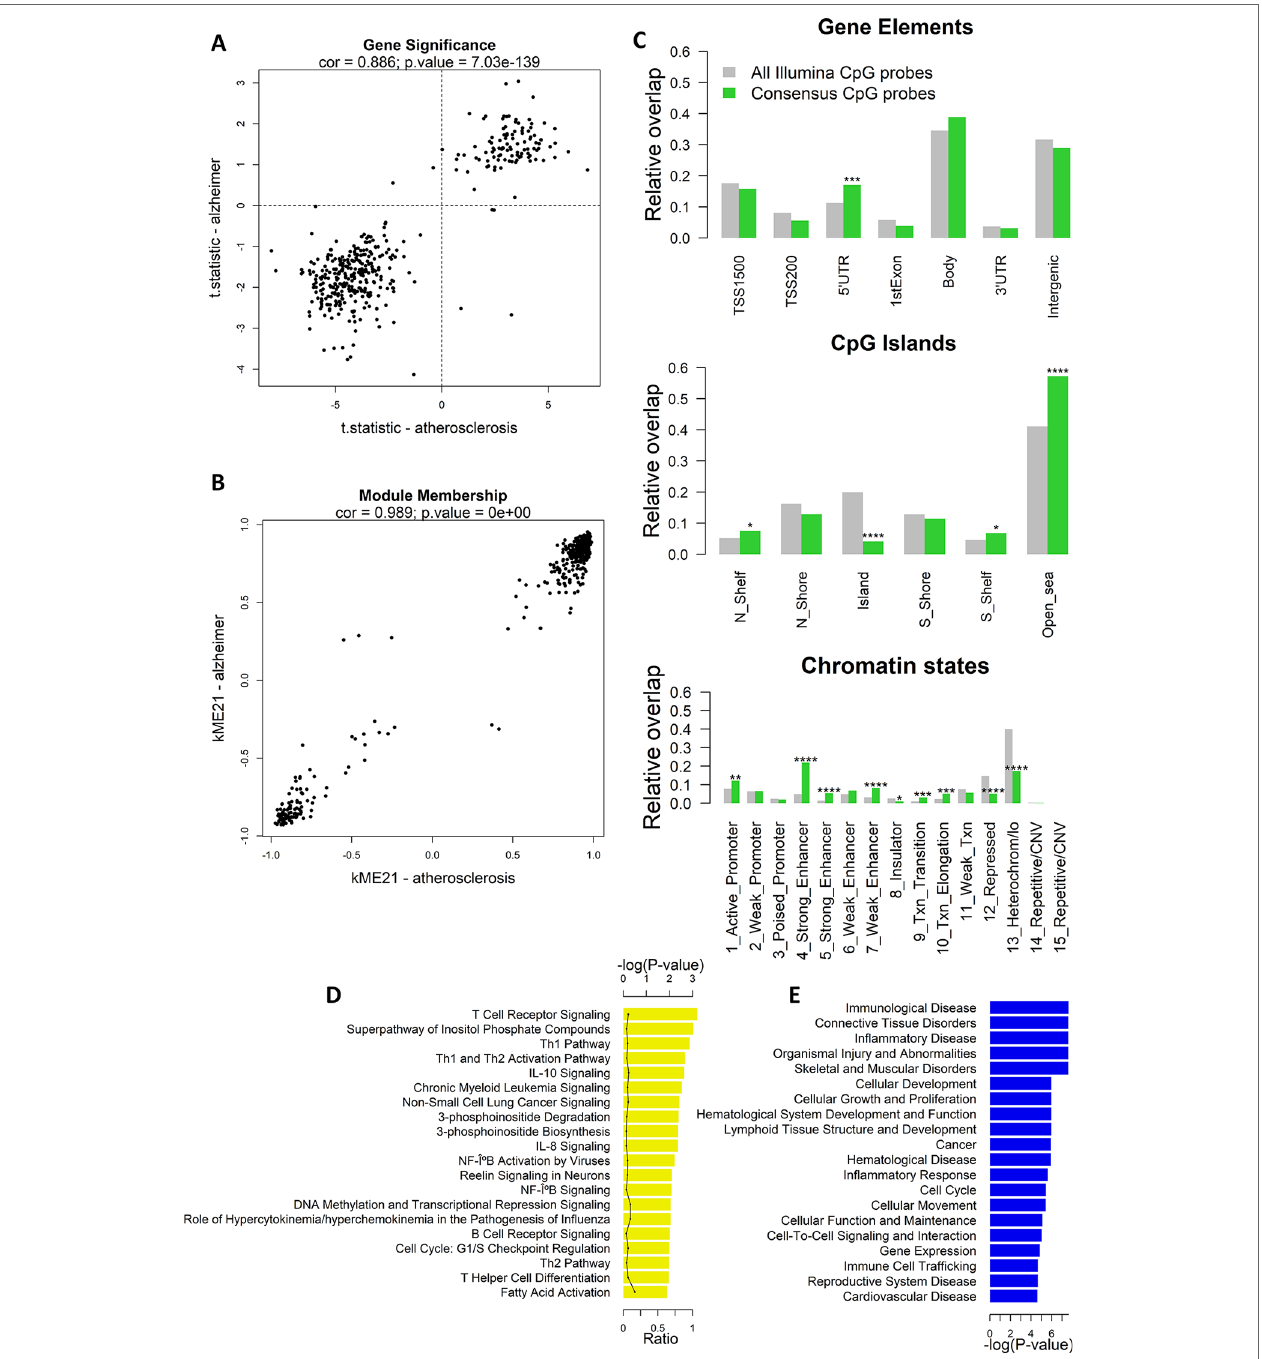
FIgURe 2 | Weighted Correlation Network Analysis (WGCNA) co-methylation consensus module in atherosclerosis and Alzheimer's disease (AD) whole blood datasets. (A) Correlation of gene significance values (t-statistics) of CpG probes in the consensus module (module ME21) between atherosclerosis and AD whole blood datasets. The Pearson's correlation coefficient and p-value are provided at the top of the scatterplot. (B) Correlation of module membership of CpG probes in the consensus module (module ME21) between atherosclerosis and AD whole blood datasets. The Pearson's correlation coefficient and p-value are provided at the top of the scatterplot. (C) Genomic enrichment of the consensus module CpG probes (module ME21) in multiple genomic regions: gene elements (top), CpG island elements (center), and chromatin segmentation states (bottom). CpG probes in module ME21 were mapped to different genomic regions and enrichment or depletion compared to all Illumina CpG probes was determined using the Fisher's exact test. Green bars represent the relative overlap of consensus module ME21 CpG probes with the genomic regions, while gray bars represent the relative overlap of all Illumina CpG probes with the genomic regions. * Fisher's exact P ≤ 0.05, ** P ≤ 0.01, *** P ≤ 0.001, **** P ≤ 0.0001. (D) Significantly enriched Ingenuity Pathway Analysis (IPA) canonical pathways, and (e) IPA diseases and biofunctions of genes containing a consensus module CpG probe. Enrichment was calculated using the Fisher's exact